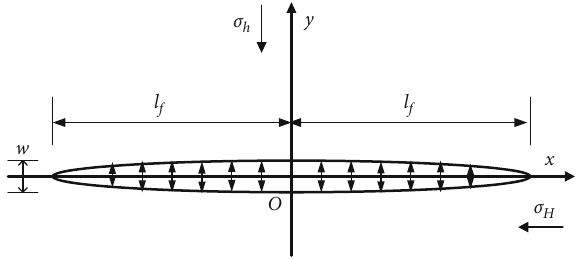
Figure 3: Schematic diagram of a naturally fractured reservoir fracture